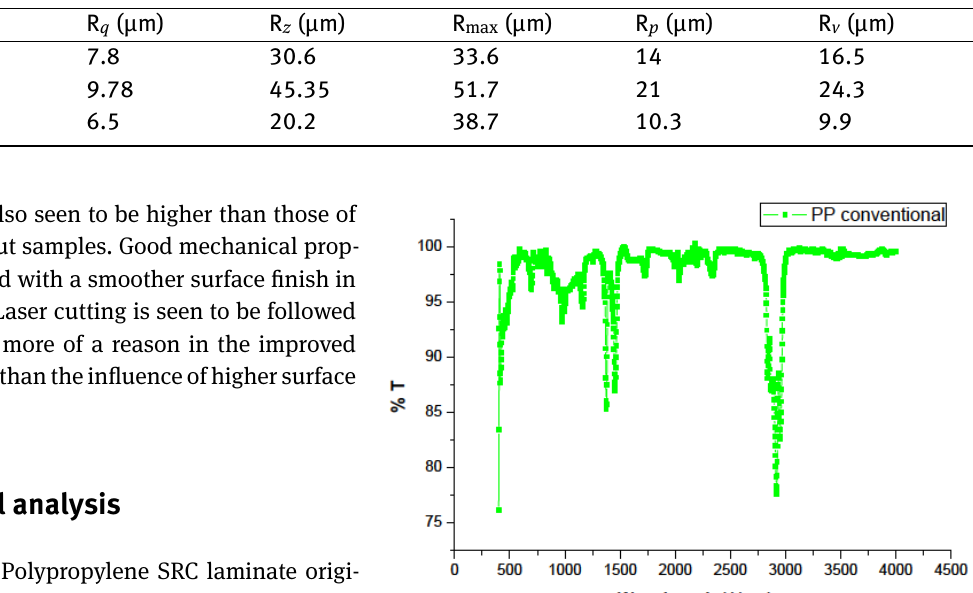
reaction of open-air during cutting as seen in Figure 8 (a). The spectrum around 1452.40 cm −1 characterized by the bending oscillation exhibited by the covalent (C–H) chain of the methyl group. Spectra at 1579 cm −1 and 1259 cm −1 attribute to the C-O aromatic ester and N-O stretching. An absorption band of 972 cm −1 is visible after AWJ machining shows alkene group which exhibits strong stretching and bending vibration. The C-C bonds have been